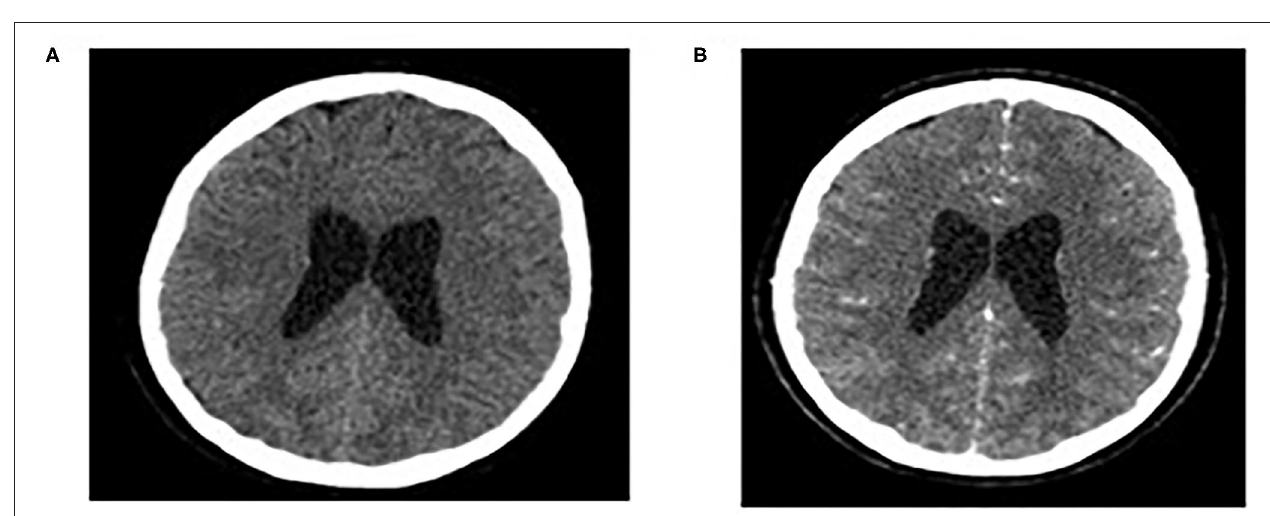
FIGURE 4 | Normal findings of brain CT scan: CT brain scan without/with intravenous contrast dye administration (A,B) .